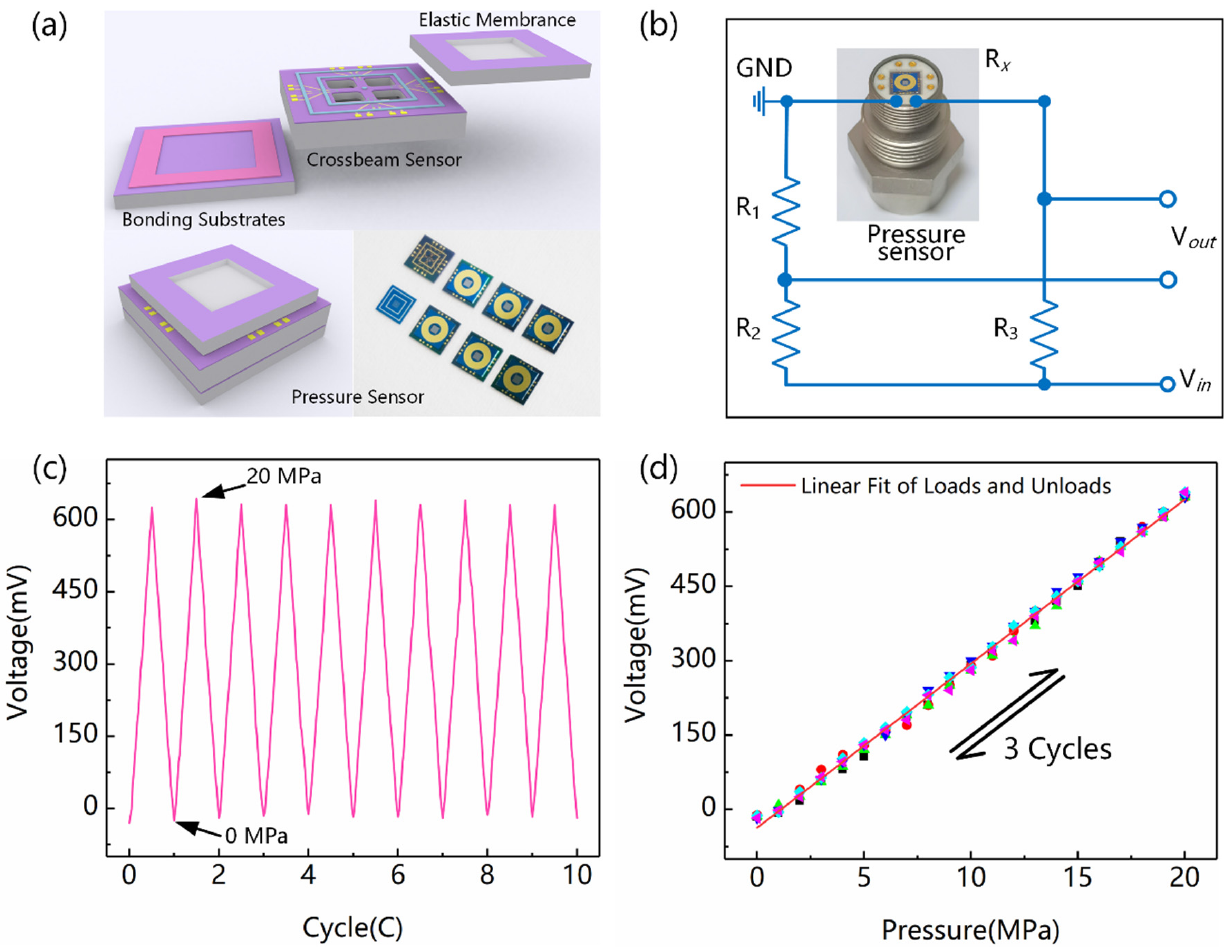
Figure 6. Packaging and testing of graphene pressure sensor based on crossbeam. ( a ) Packaging schematic and actual chip of sensor. ( b ) Shell assembling and electrical connection of sensor. ( c ) Test results of 10 load–unload cycles in full–range condition. ( d ) Test results of 3 reciprocating cycles.